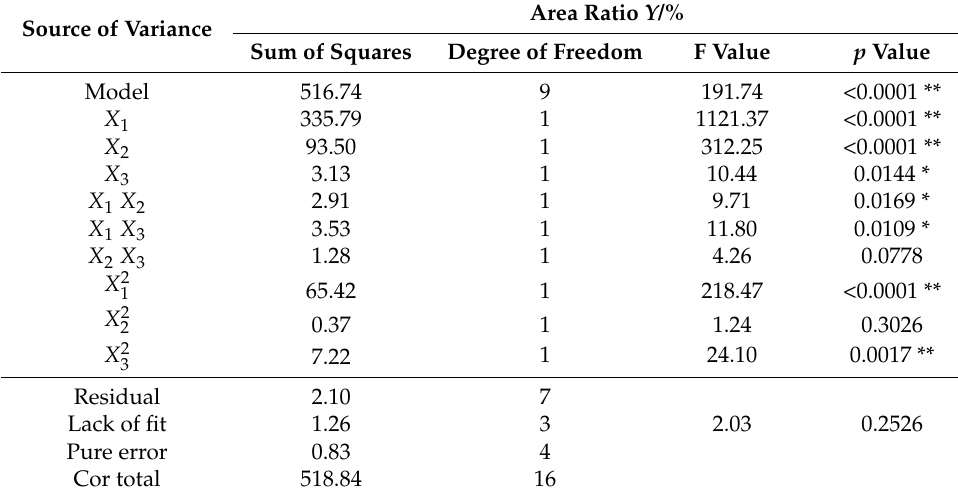
Table 5. Analysis of variance of regression